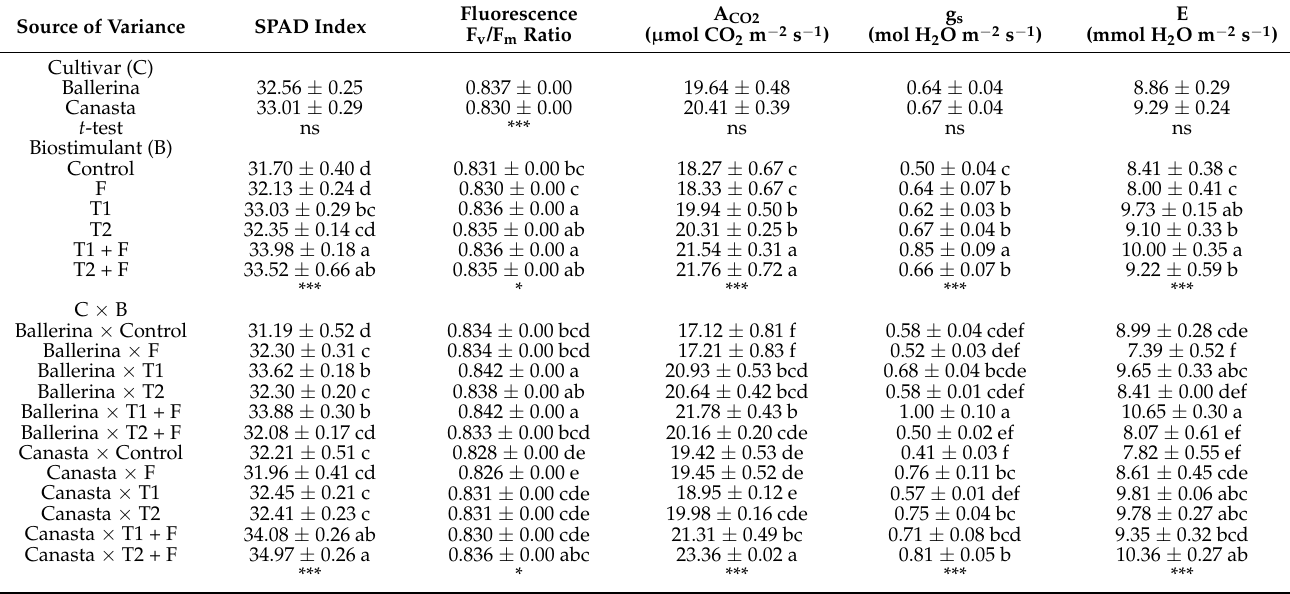
All data are expressed as mean ± standard error, n = 3. ns, *, *** non-significant or significant at p ≤ 0.05 and 0.001, respectively. Cultivars means were compared by t -Test. Different letters within each column indicate significant differences according to Duncan’s